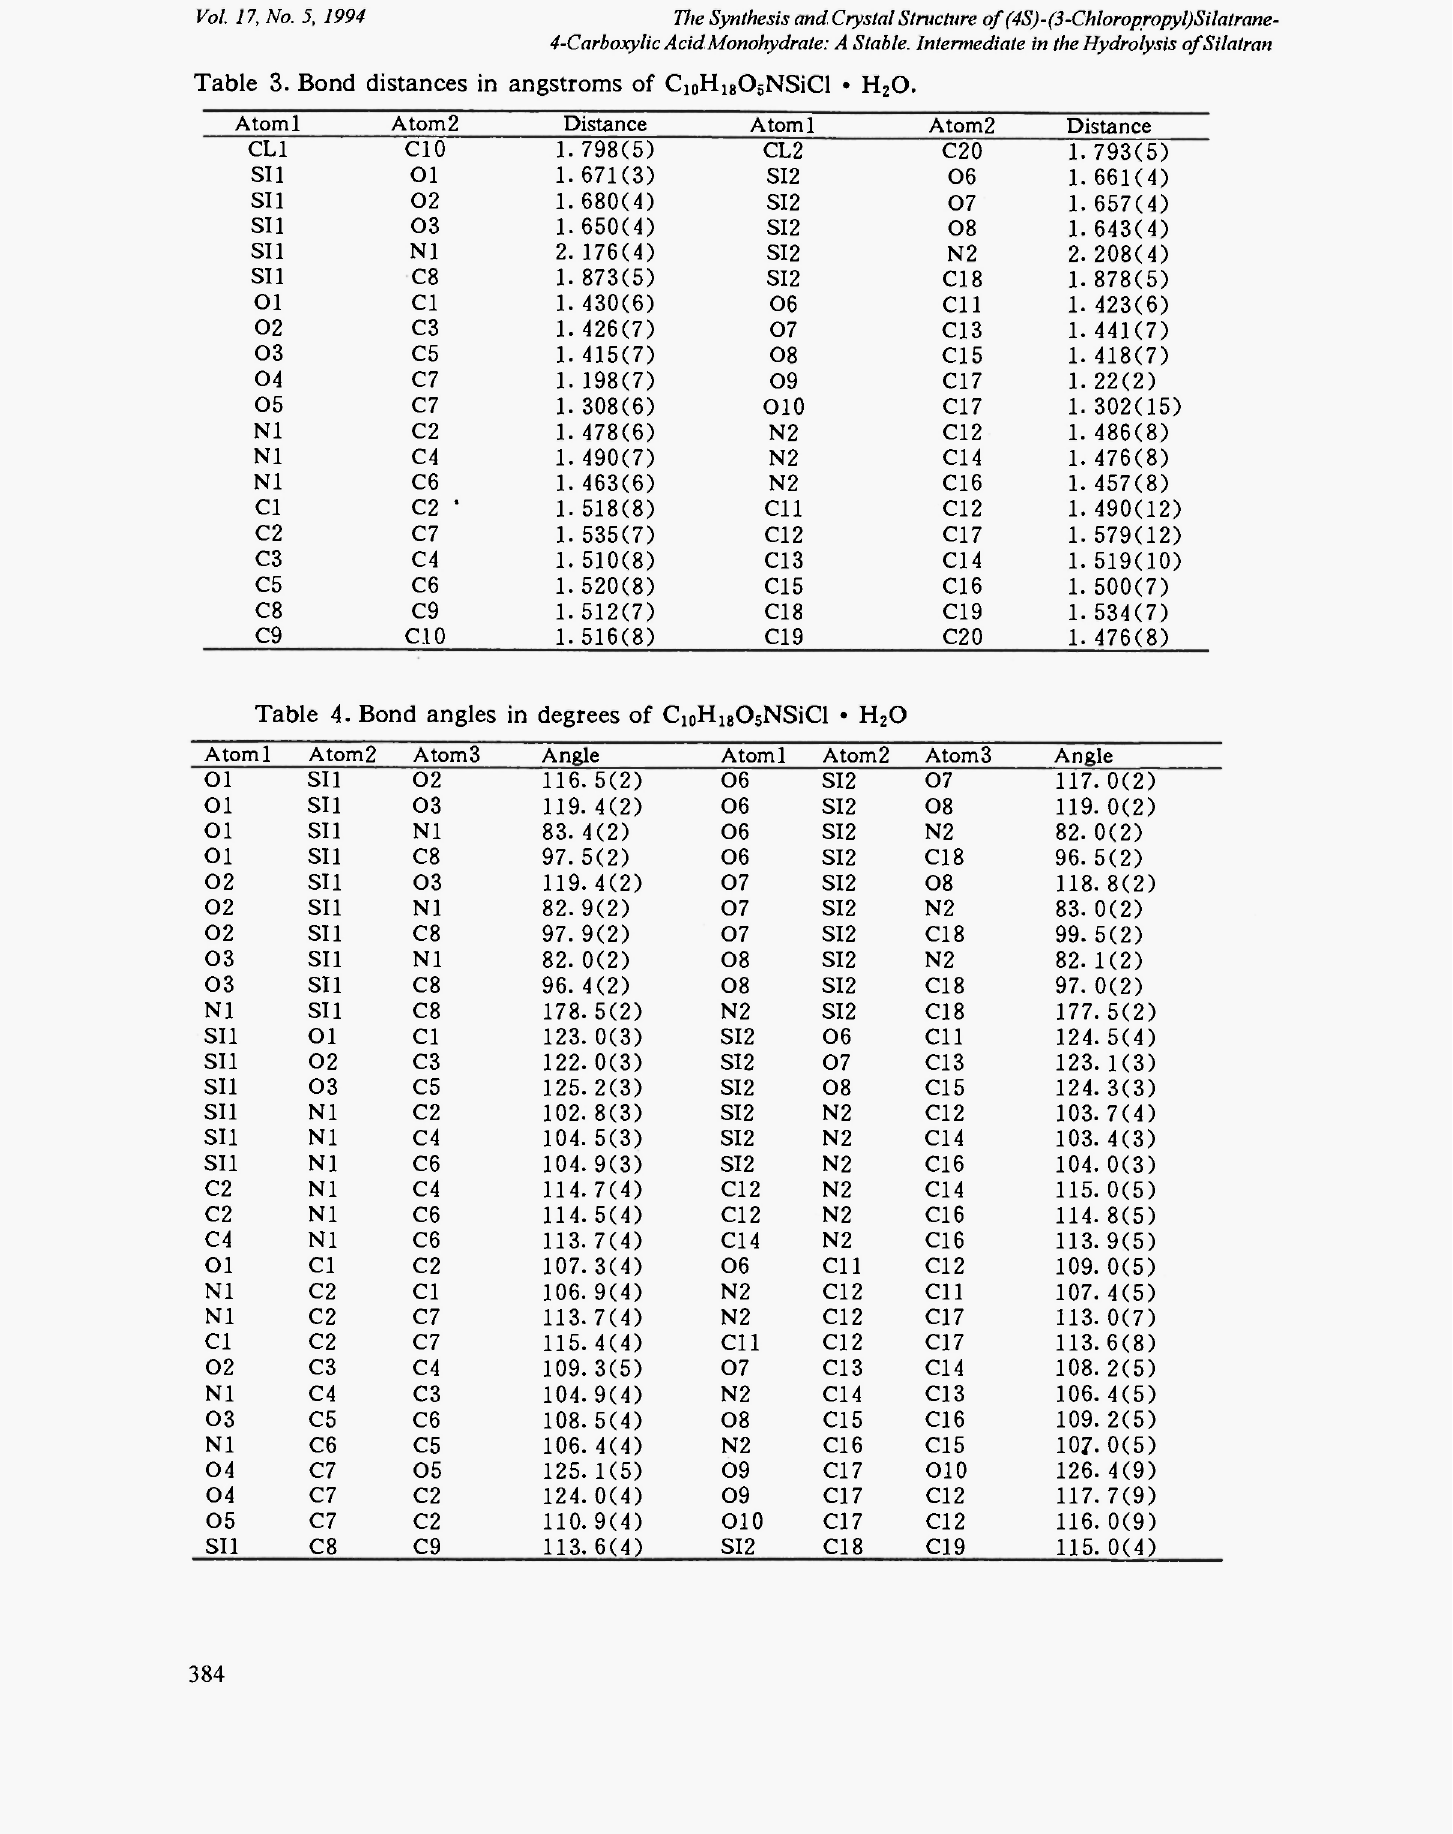
Table 3. Bond distances in angstroms of C